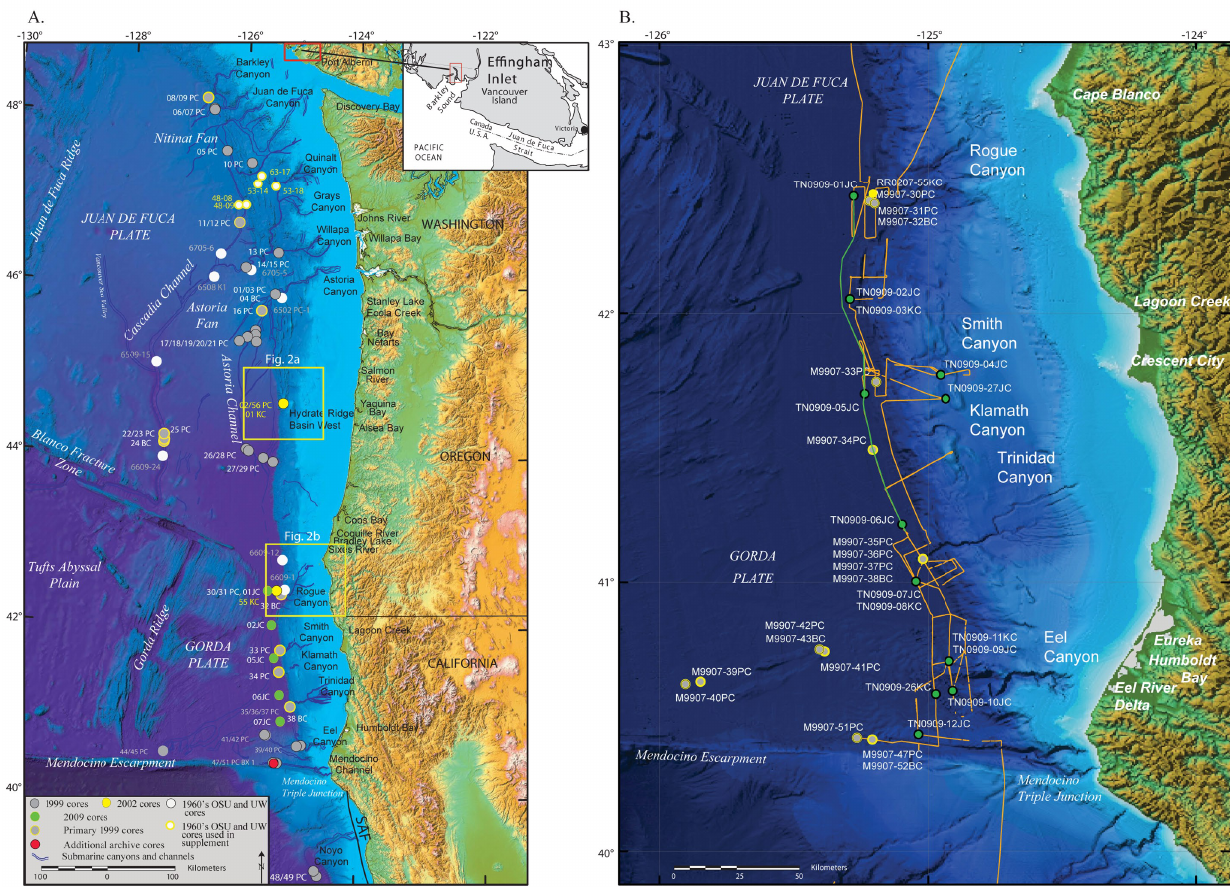
Fig. 1. (A) Cascadia margin turbidite canyons, channels and 1999–2002 core locations. Major canyon/channel systems are outlined in blue. Primary core sites shown with yellow rim, all other 1999–2002 cores are grey. Selected earlier UW and OSU cores shown in white. PC, piston core; BC, box core; KC, kasten core; GC, gravity core; TC, trigger core. Trigger cores omitted for clarity. Inset of Effingham Inlet shows collection site of Pacific Geoscience Centre (PGC) collected piston cores. Yellow boxes indicate approximate areas of Fig. 2a and b. Key onshore paleoseismic sites shown. (B) Southern Cascadia continental margin bathymetry and core sites in greater detail. Core symbology as in (A) . The 3.5kHz Chirp profile tracklines are shown. Segments used in Figs. 9 and 10 shown in green, others in orange. Key onshore paleoseismic sites